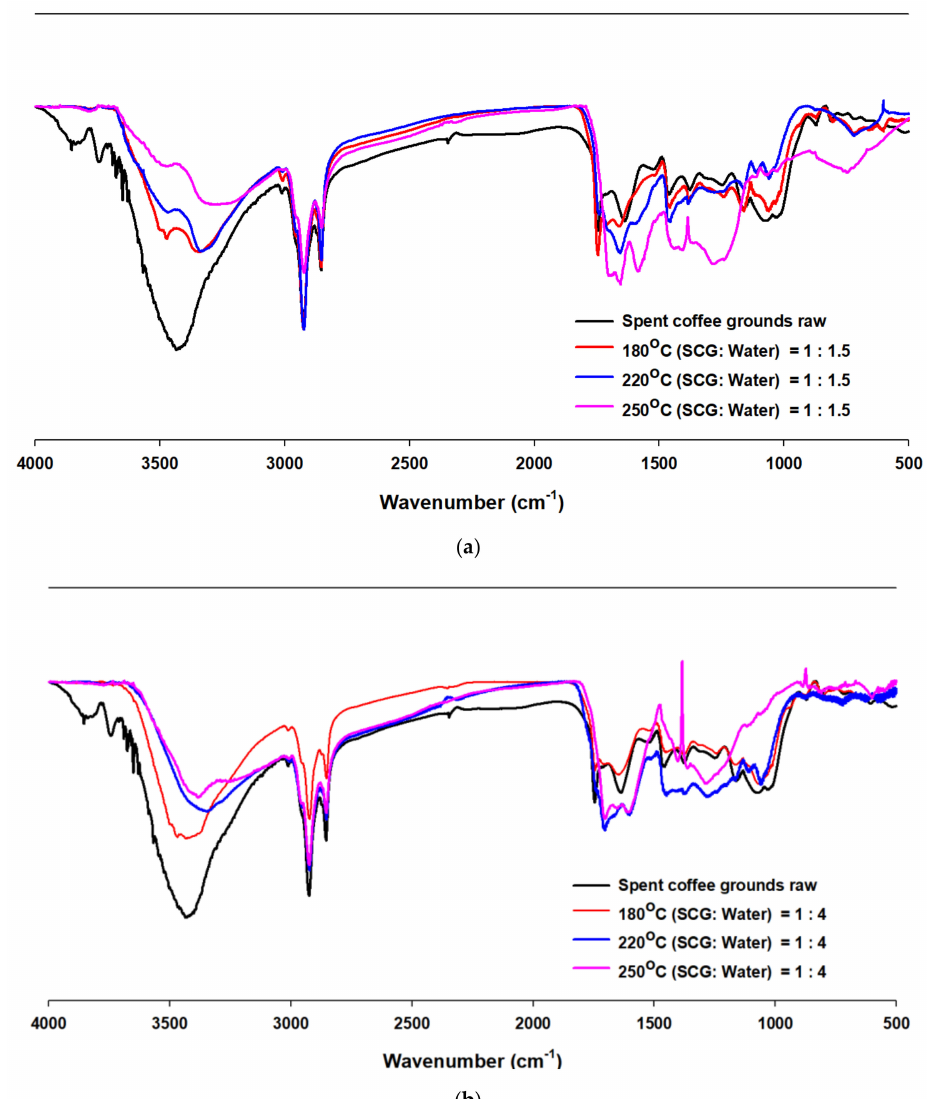
Figure 11. Fourier transform infrared spectroscopy (FT-IR) spectra of raw and hydrothermally carbonized SCGs produced with different reaction temperatures and water contents: ( a ) SCG: water = 1:1.5; ( b )